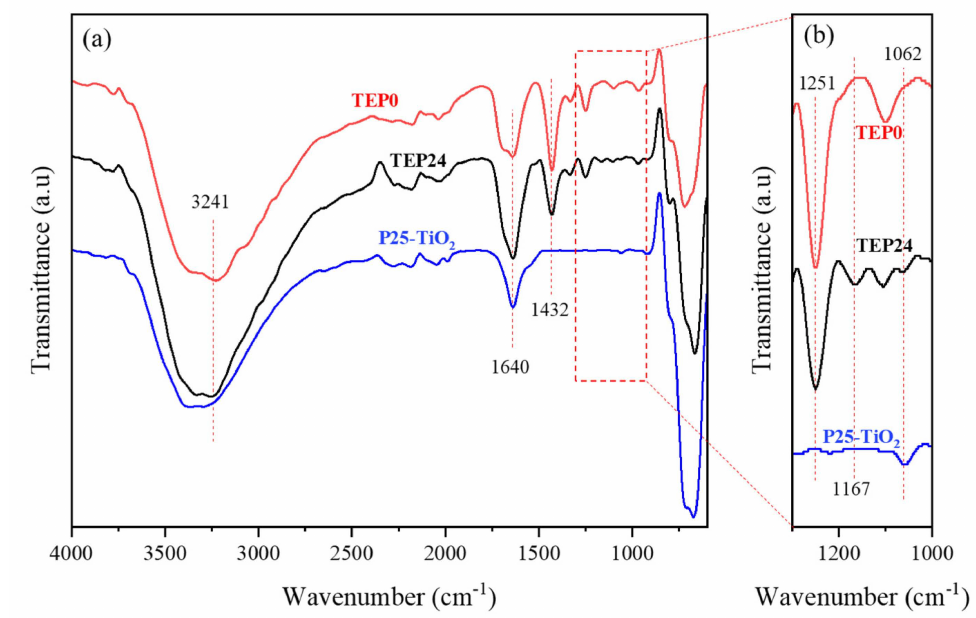
Figure 8. Comparison of Fourier transform infrared (FTIR) analysis between TEP0, TEP24, and de- gussa P25–TiO 2 in ( a ) a wide range wavenumber (4000–600 cm − 1 ) and ( b ) narrow range wavenumber (1300–1000 cm − 1 ).